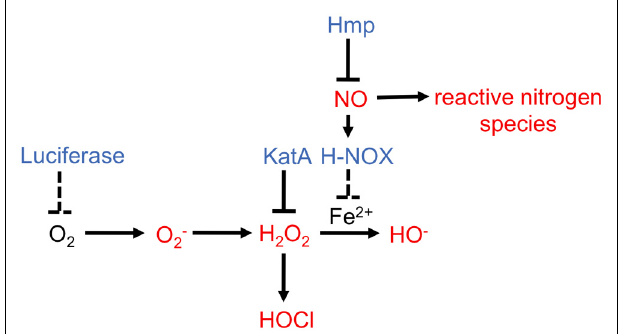
FIGURE 5 | Reactive oxygen species and reactive nitrogen species pathways and V. fischeri proteins potentially involved in modulating synthesis of these antimicrobials. ROS and RNS are indicated in red (Fang, 2004; Bowman etal., 2011). V. fischeri enzymes that have been demonstrated (solid line) or predicted (dashed line) to modulate levels of potential antimicrobial molecules are indicated in